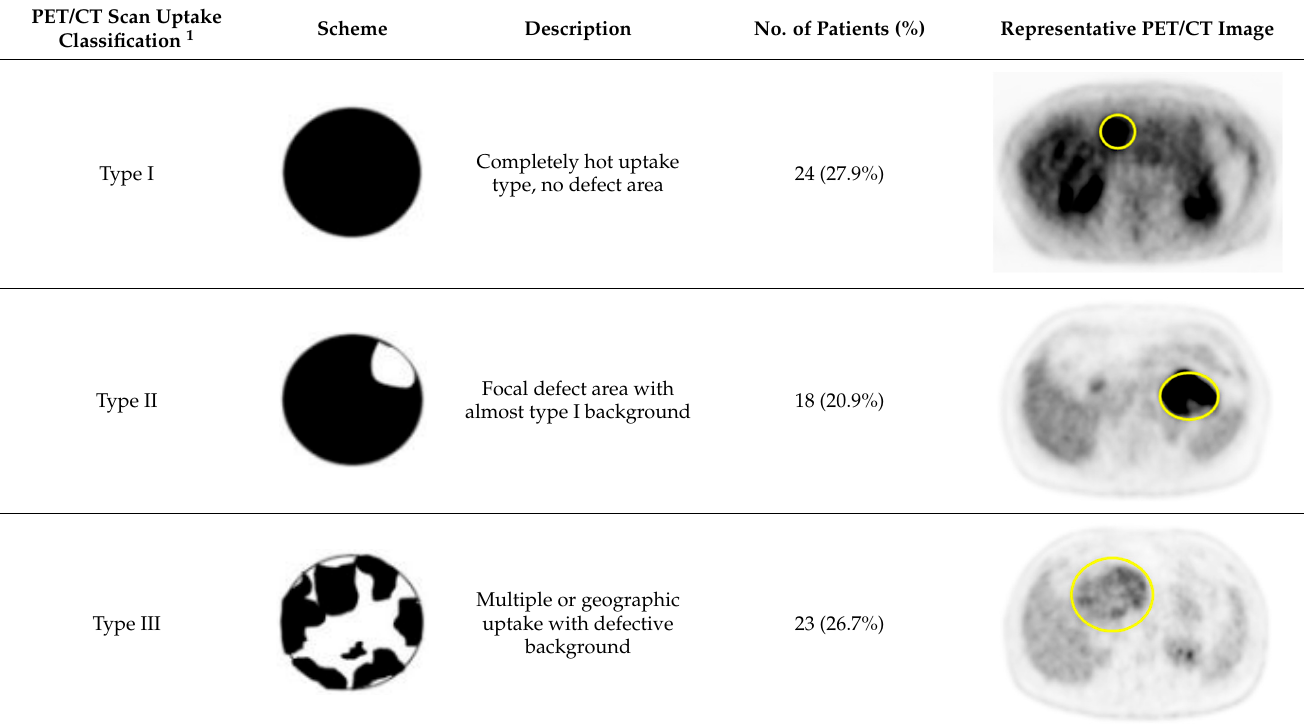
Table 2. Clinical pattern of preoperative PET/CT in all 86 patients.